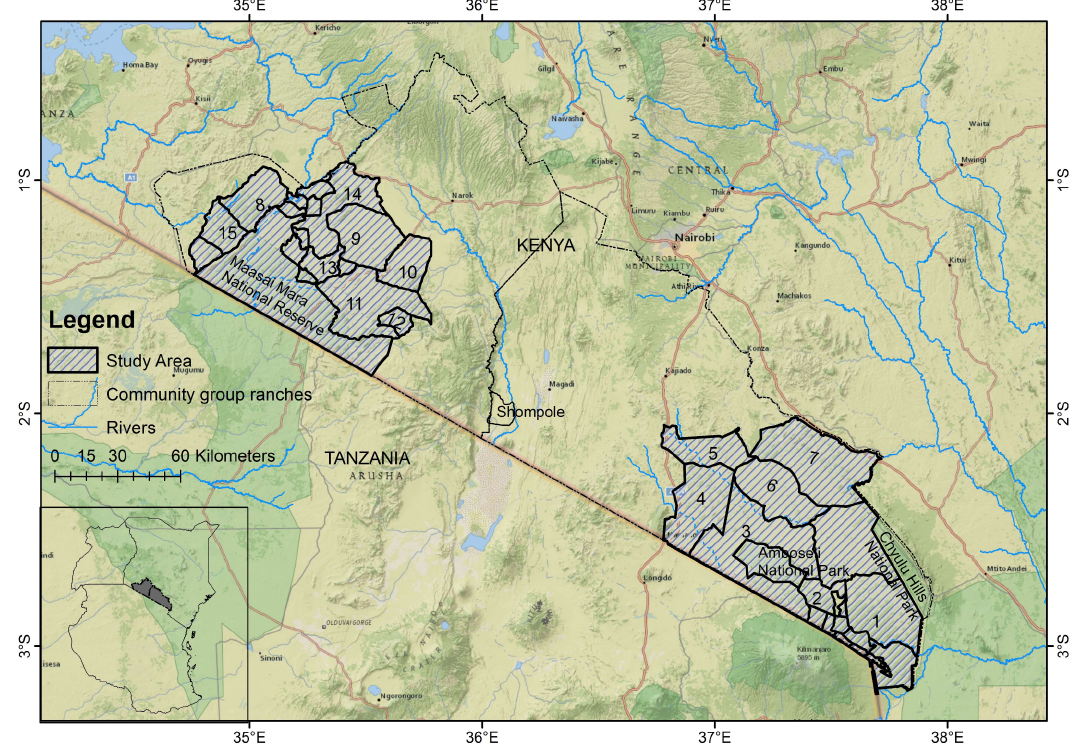
Figure 1. Amboseli and Mara ecosystems in southern Kenya and the surrounding group ranches (numbered 1–15). Group ranches 1 to 7 are in Amboseli while group ranches 8 to 15 are in the Mara. The name for the numbered group ranches are as follows: 1—Kuku,